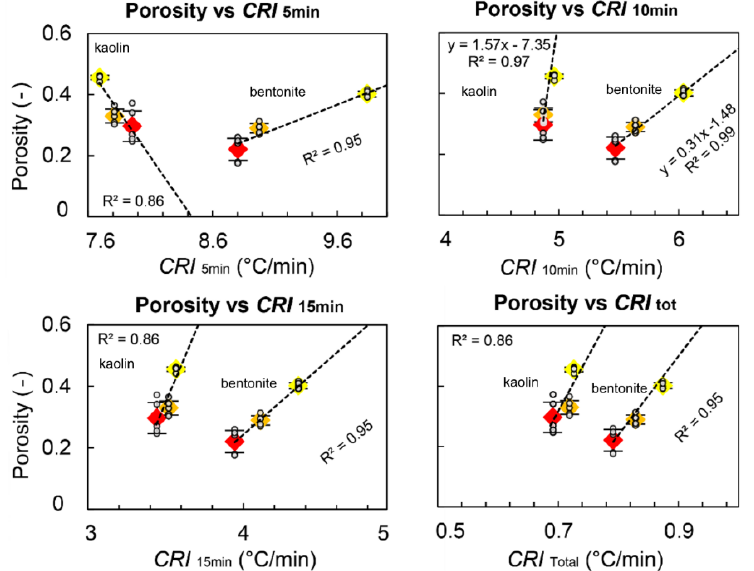
Figure 5. Linear regression analysis between porosity and CRI according to different durations since the beginning of cooling: 5 min (top left); 10 min (top right); 15 min (bottom left); entire cooling phase (bottom right). Values for kaolin plot in th left portion of each graph (lower CRI), while those for bentonite plot in the right portion (higher CRI). The diamonds represent the mean values for disks, while small circles represent the distribution of values of all disks. Colours yellow, orange, and red, represent, respectively, samples compacted under 1 ton, 3 tons, and 5 tons. With respect to the correlation with the critical state friction angle, this has been ex-